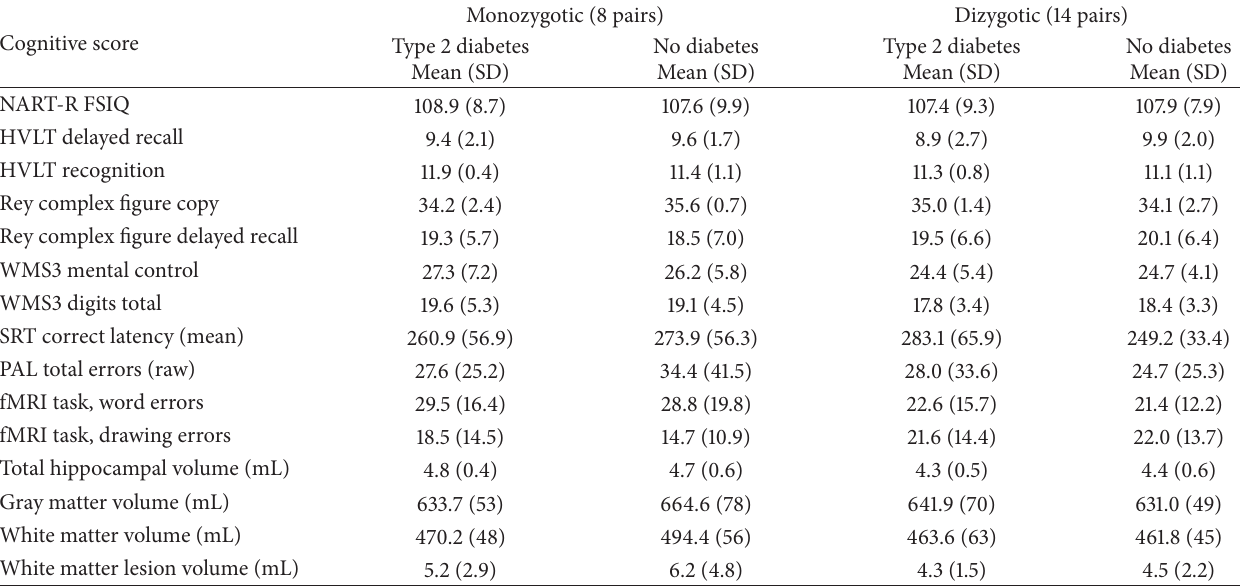
Table 2: Cognitive scores and brain volumes stratified by zygosity a .